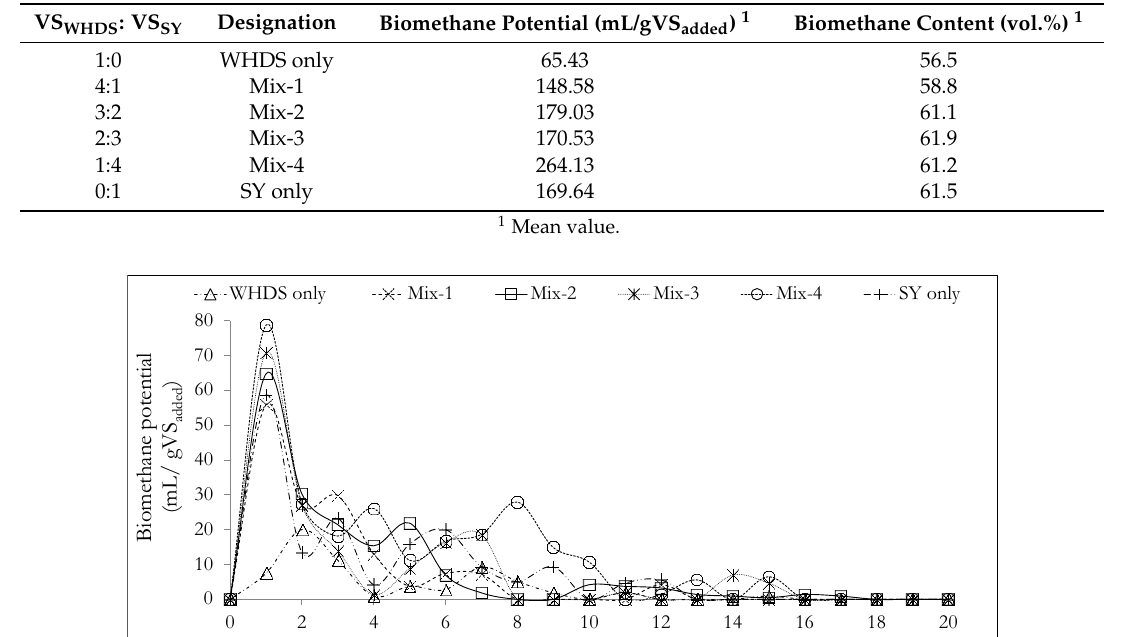
Table 3. Biomethane potential and biomethane contents of biogas generated from the degradation of the different substrate mixtures.